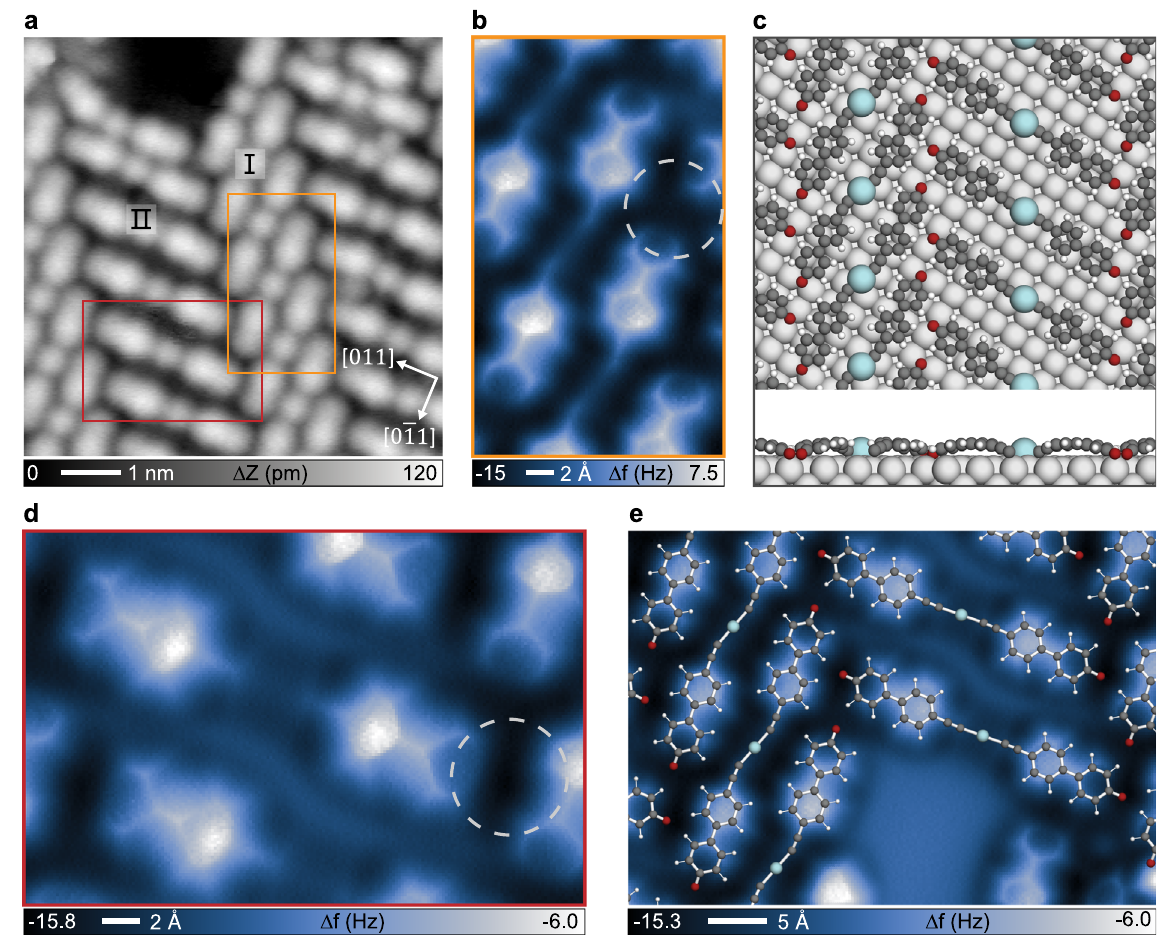
Fig. 3 | Formation of organometallic ribbon phase via O 2 mediated on-surface reactions. a Representative STM image revealing dimeric organometallic con- stituents and their mutual arrangement. b , d Bond-resolved nc-AFM images of the dimers corresponding to the area marked with orange and red rectangles in ( a ), respectively. The dashed circles indicate the intermolecular interaction modes